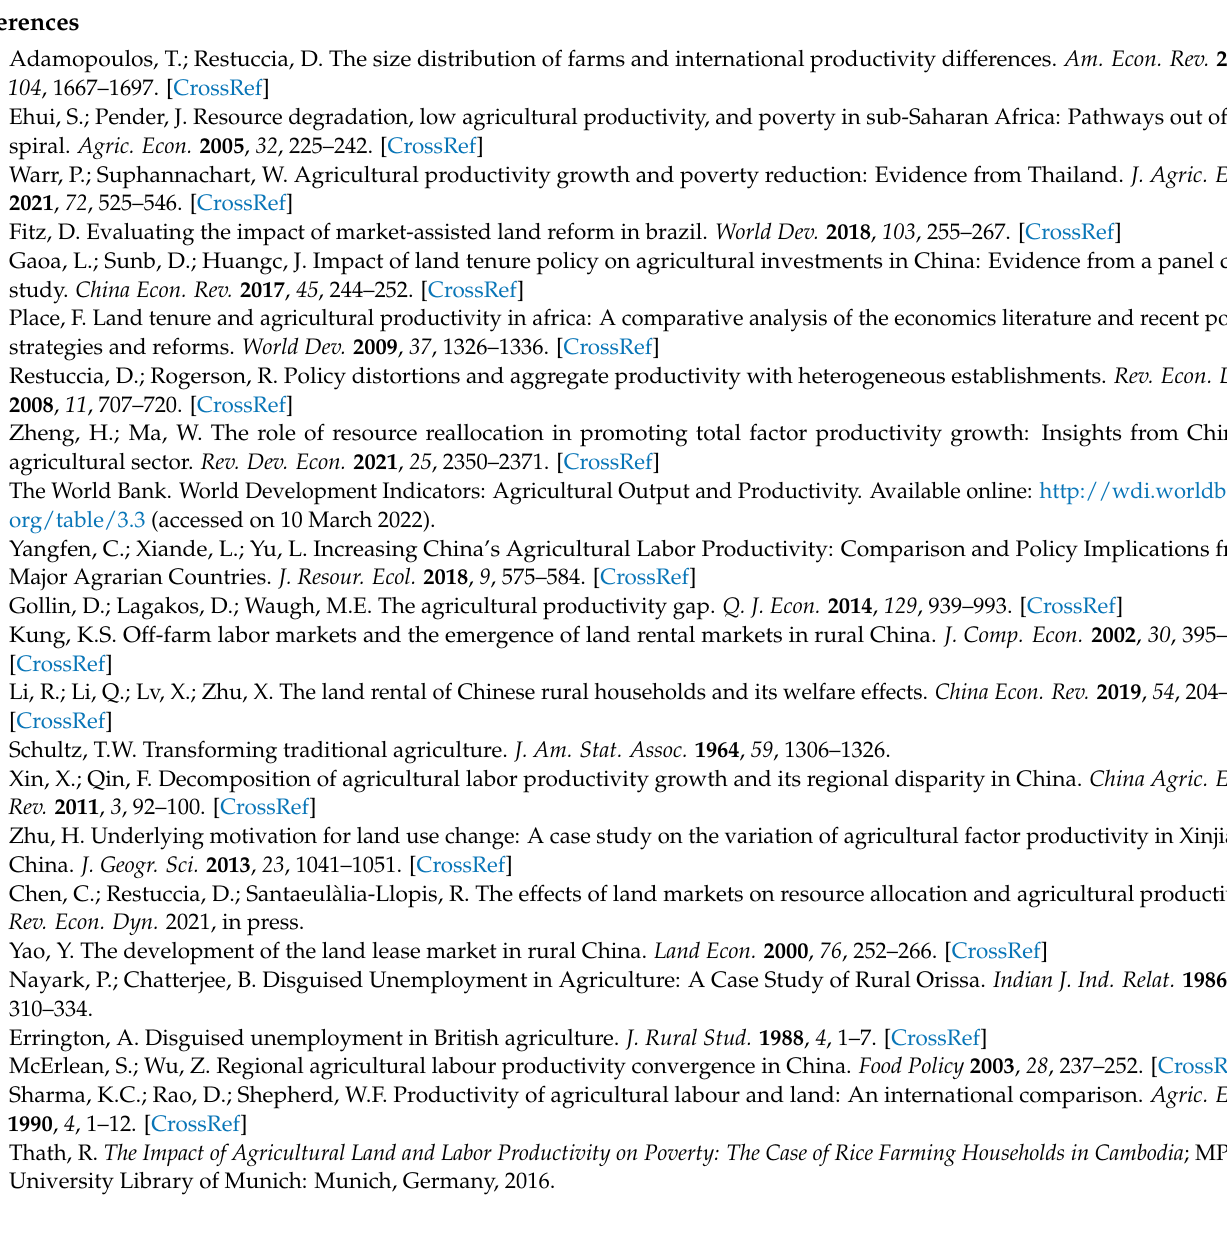
Figure A1. Common support of propensity score (based on NNM). ( a ) Propensity score of renting-in; ( b ) Propensity score of